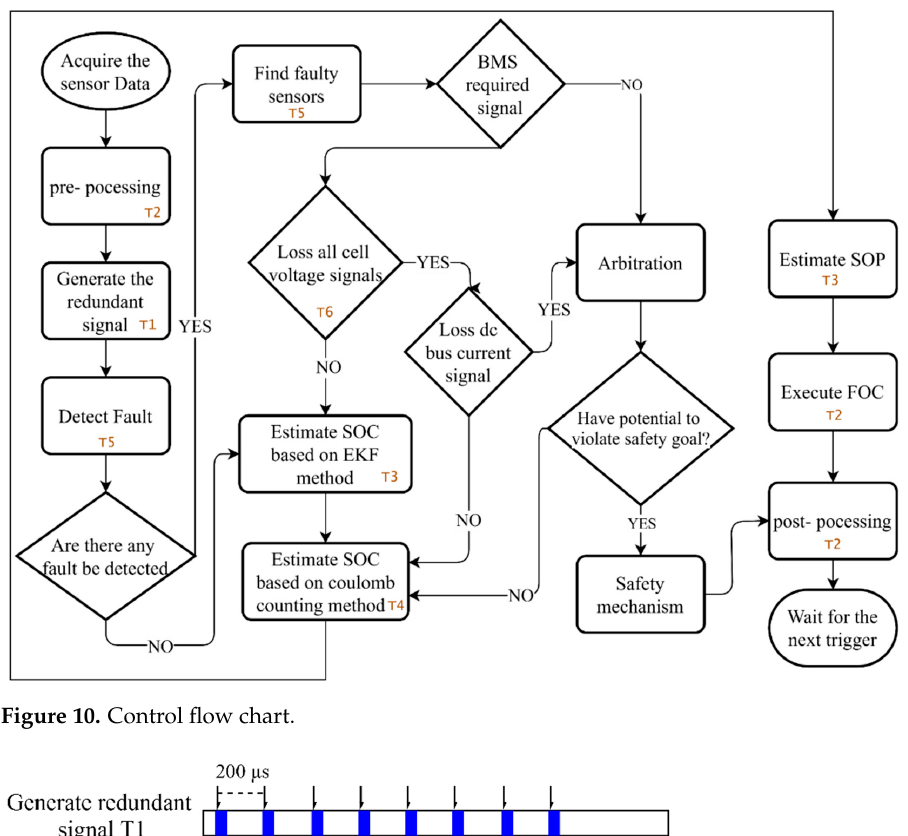
Figure 10. Control flow chart.